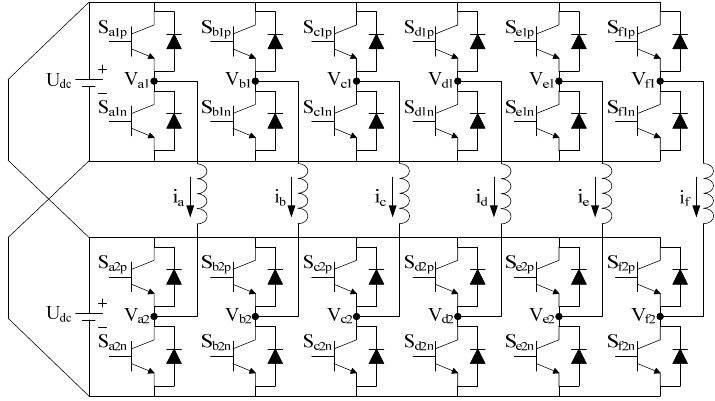
Figure 7. Cascaded VSC feeding the semi-twelve-phase open-winding PMSM.